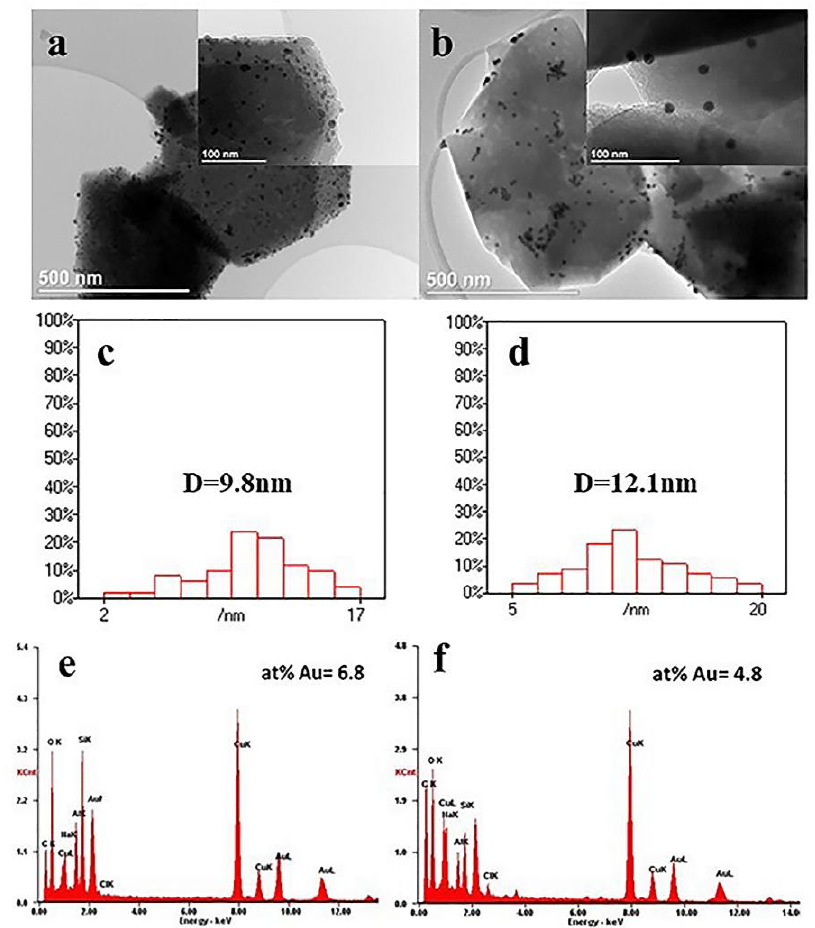
Figure 8. TEM images and EDS results of AuNPs immobilized zeolite: ( a ) TEM of Au@zeolite-APTES; ( b ) TEM of Au@zeolite-MPTES; ( c ) gold size distribution of Au@zeolite-APTES; ( d ) gold size